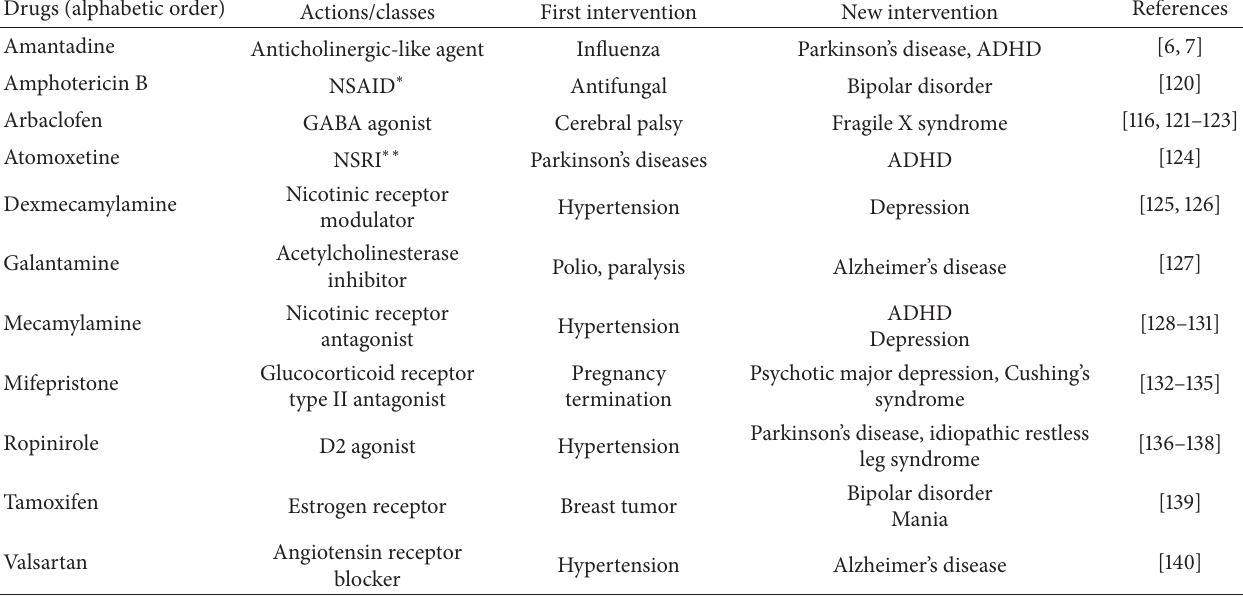
Table 2: Some examples of repurposed drugs for neuropsychiatric